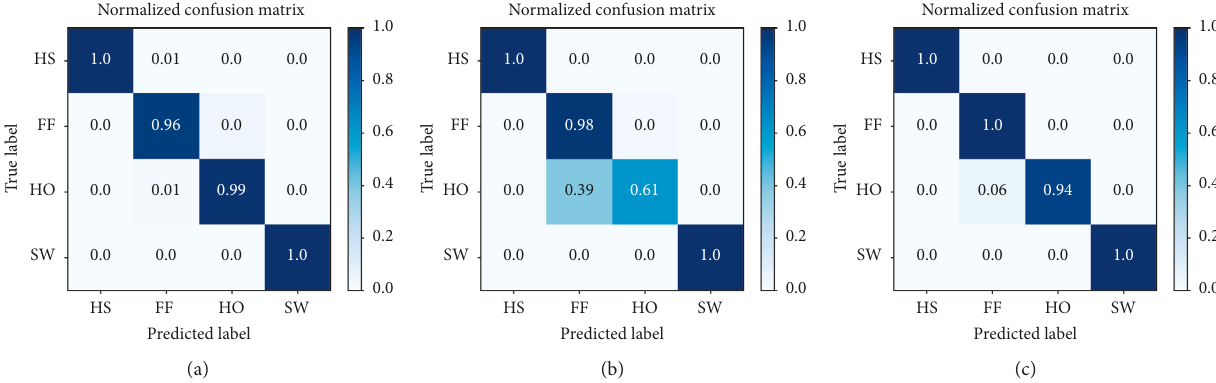
Figure 9: Confusion matrix of three gait patterns derived from AdaBoosting classification under three pace settings: 0.78m/s (a), 1.0m/s (b), and 1.25m/s (c) classes.